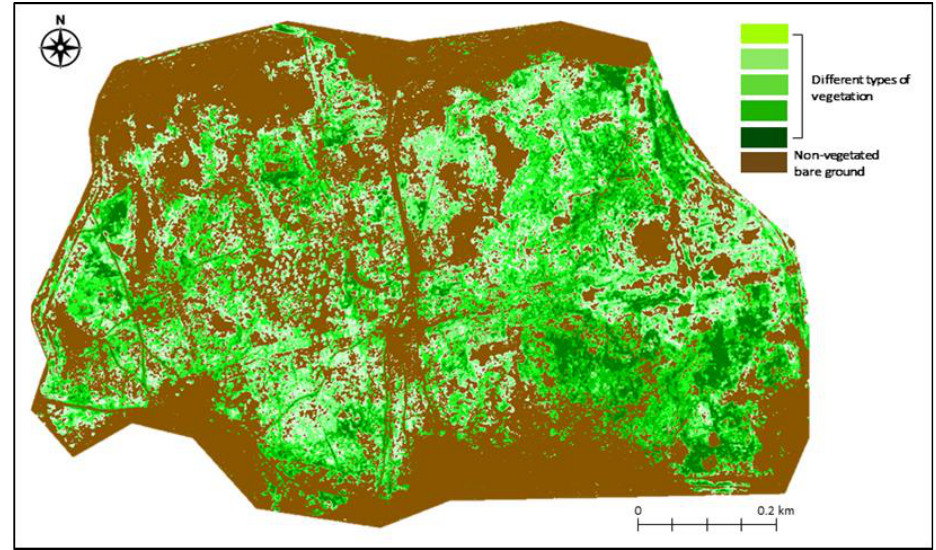
Figure 4. MNF-based K-Means classification showing vegetated versus non-vegetated (bare ground) land cover.